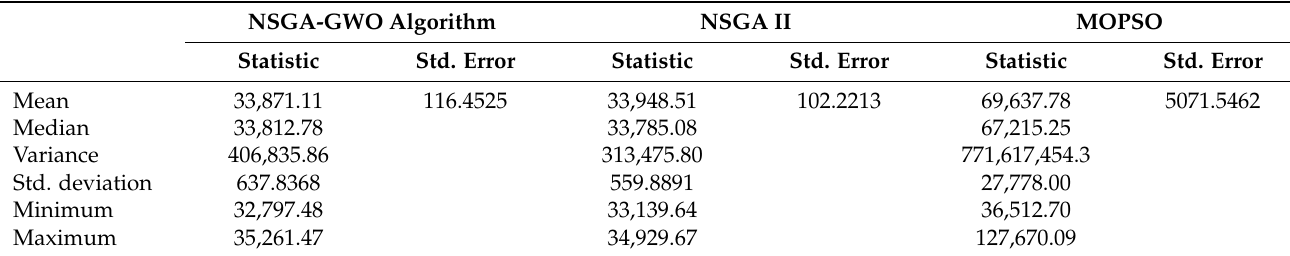
Table 4. Statistical descriptive.